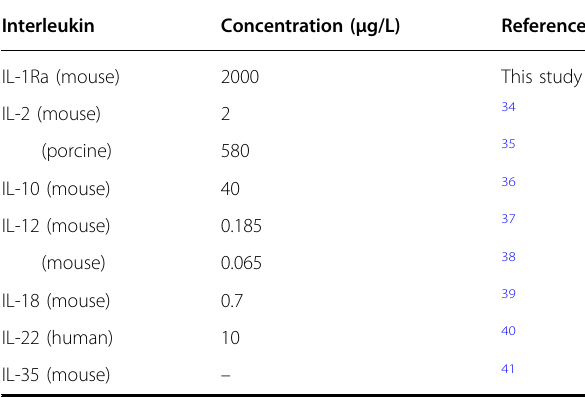
Table 1 Quantity of recombinant interleukin, as determined using the NICE